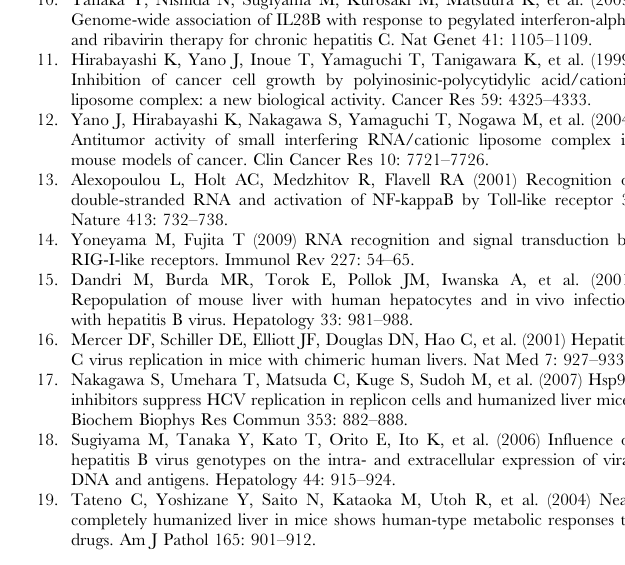
expressed as a percentage of the untreated control ( n = 4 per group). Data are mean values and the bars indicate SD. ** P , 0.01, IFN treatments vs. the vehicle by Dunnett’s multiple comparison test. Figure S8 The anti-HBV response elicited by IFN- l . Serum HBV genomic DNA levels were assayed in chimeric mice infected with HBV and administered daily treatments of recombinant human IFN- l 2 or LIC-pIC. HBV levels were assayed on the indicated days after the initial treatments. Values are expressed relative to the baseline value. Data points indicate mean values and the bars indicate SD ( n = 3–5 per group). ** P , 0.01, treatments vs. the saline control by Dunnett’s multiple comparison test. Figure S9 Neutralizing activity of anti-human IFN- l antibodies. FLR 3-1 HCV replicon cells were pre-treated with 1 m g/ml or 10 m g/ml of anti-human IFN- l 1 or anti-human IFN- l 2 antibodies before the addition of recombinant human IFN- l 1, IFN- l 2, or IFN- l 3 to the culture medium. The replication of HCV replicons was determined by luciferase assays (red bars), and cell viability was determined using a WST-8 assay (gray bars). Values are expressed as a percentage of the untreated control. Data points are mean values and the error bars indicate SD ( n = 4 per group). Figure S10 Induction of IFN- l s by LIC-pIC and antiviral effect in human hepatocytes with genetic variants near the IFNL3 ( IL28B) gene. Chimeric mice were transplanted with human hepatocytes from donors bearing a T- or G-allele of the rs8099917 ( IFNL3 -proximal) SNP. Animals were infected with HCV genotype 1b and treated daily with LIC-pIC. ( A ) The liver mRNA levels of human IFN- l -encoding genes ( IFNL1 , IFNL2 , and IFNL3 (also known as IL29, IL28A, and IL28B , respectively)) were assayed by qRT-PCR. ( B ) The serum HCV genomic RNA levels were assayed by qRT-PCR. Values are expressed relative to the baseline value. Data points are presented as mean values with SD ( n = 1–6 per group). ** P , 0.01, treatments vs. the saline control by Dunnett’s multiple comparison test.